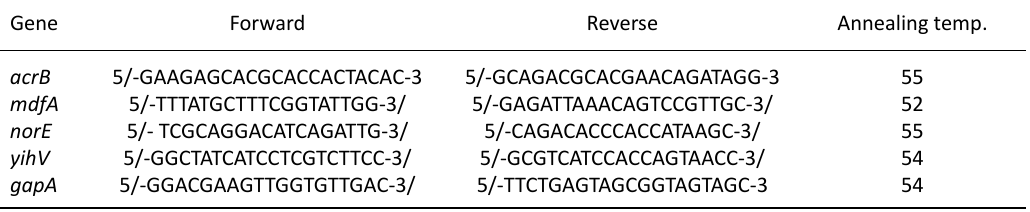
Table 1. Primers and annealing temperatures utilized in qRT-PCR Gene Forward